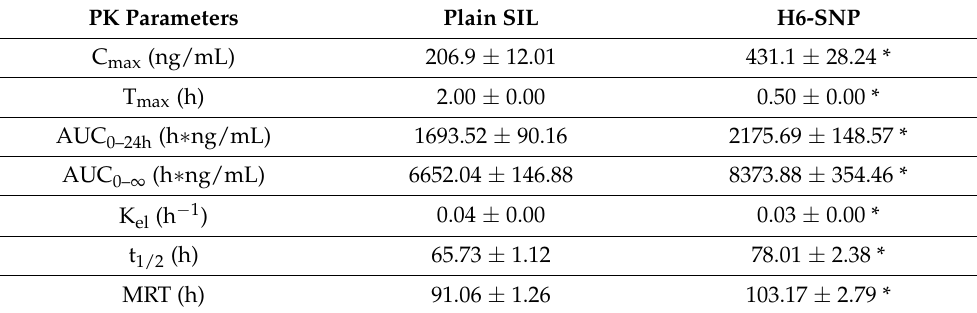
Table 8. Pharmacokinetic profile of SIL and